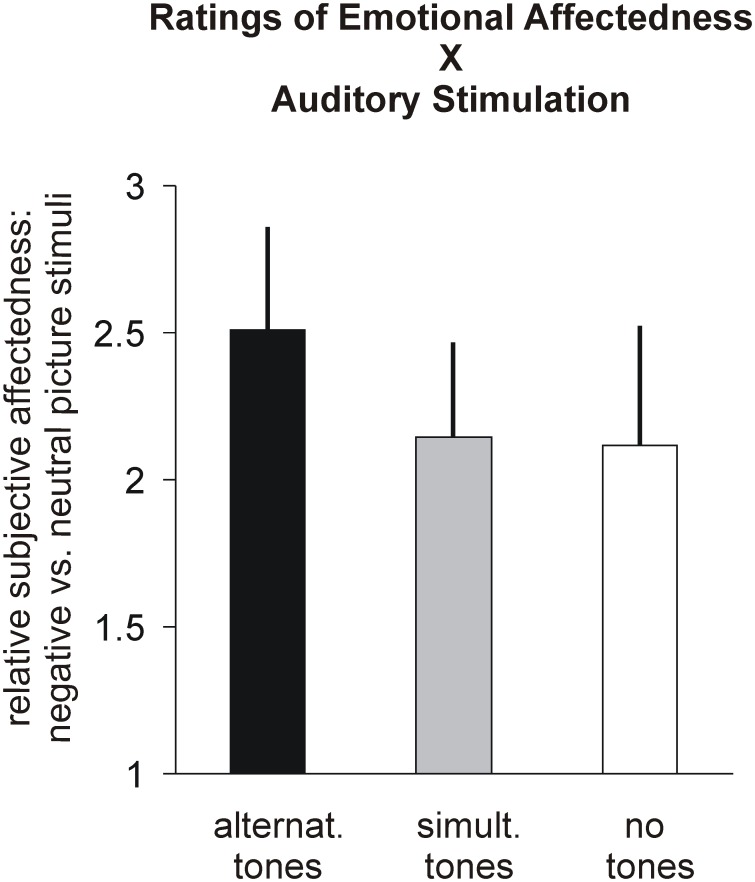
Subjective affectedness by emotional pictures.Relative ratings of how much subjects felt emotionally affected by the pictures depending on the type of auditory stimulation. Subjects were asked for their statements after scanning using a paper and pencil questionnaire showing the same pictures as in the scanner in a randomized order (the order was different from that in the scanner) and without a link to the auditory stimulation used before. Depicted are the mean differences of individual ratings of emotional vs. neutral pictures and standard errors. No significant differences were found.